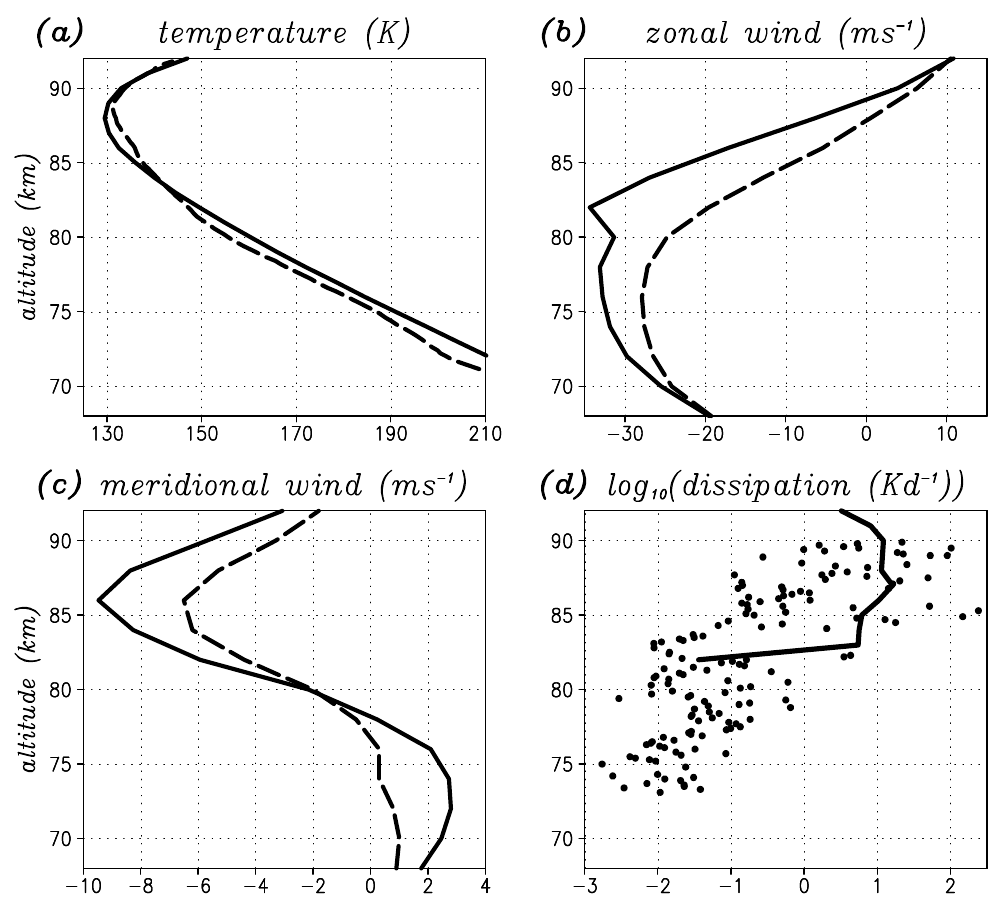
Fig. 1. The mean thermal and dynamical structure of the summer MLT at Andøya in years prior to 2002 (solid curves) and during the MaCWAVE/MIDAS campaign 2002 (dashed curves or dots). (a) Temperature based on falling sphere soundings. (b) , (c) Mean horizontal winds obtained with the ALOMAR MF radar between June 15 and July 15, 2005. (d) Turbulence dissipation rates based on CONE rocket soundings. For details of the different data sets see Goldberg et al. (2004), Singer et al. (2005), and Rapp et al. (2004).